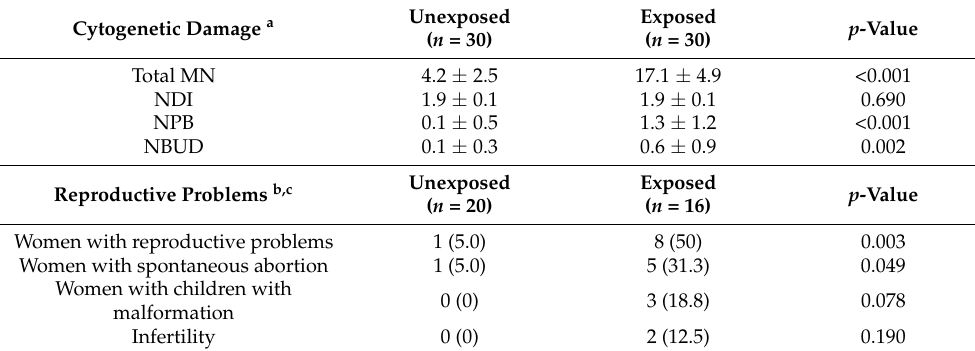
Table 2. Cytogenetic damage levels and frequency of reproductive problems between